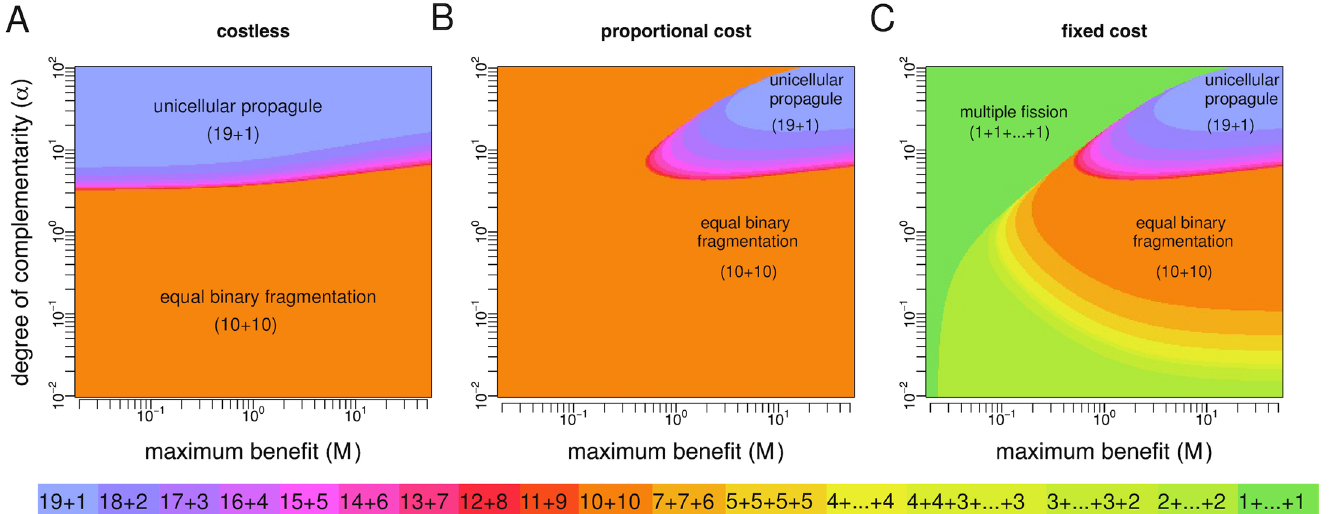
Fig 6. Optimal life cycles under monotonic fecundity landscapes. Birth rates are given by b i = 1 + Mg i where g i = [( i − 1)/( n − 2)] α . A Costless fragmentation, n = 20. B Fragmentation with proportional costs, n = 21. C Fragmentation with fixed costs, n = 21. For costless fragmentation and fragmentation with proportional costs, only binary modes 19+1, 18+2, ... , 10+10 are optimal. In these cases, diminishing returns ( α < 1) make equal binary fragmentation (10+10)optimal. Also, optimalityof the unicellular propagulestrategy (19+1) requiresincreasingreturns ( α > 1). For fragmentation with fixed costs, nonbinarymodes 7+7+6, ... , 1+ ... +1 can also be optimal.